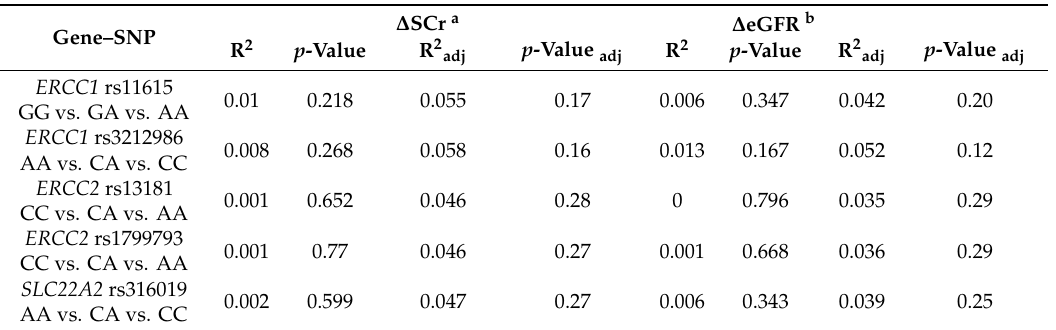
Table 9. Multiple linear regression analysis results between genetic polymorphisms and ∆ SCr and ∆